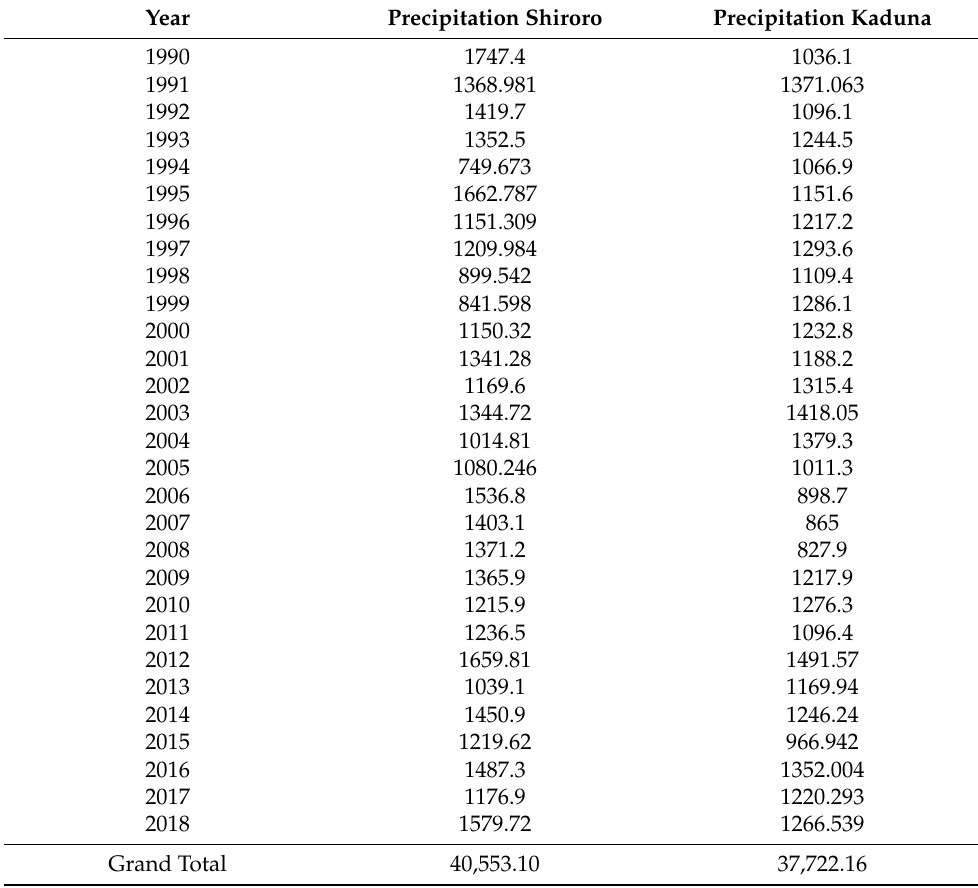
Table A1. Rainfall records of Shiroro and Kaduna Meteorological stations 1990 to